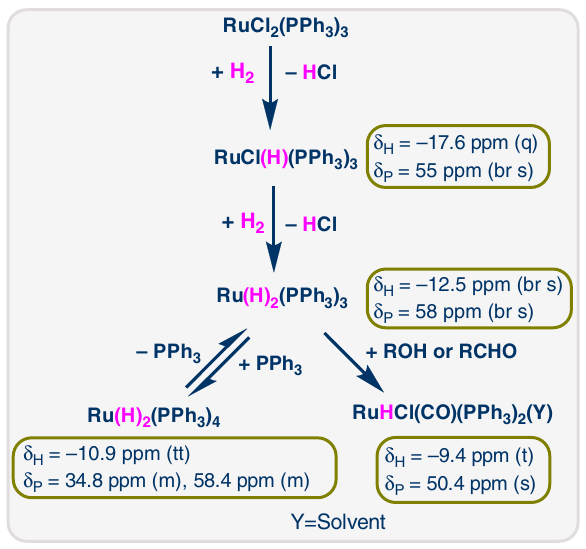
Fig. 7 Generation of different species from RuCl 2 (PPh 3 ) 3 in presence of hydrogen. RuCl 2 (PPh 3 ) 2 = precatalyst; Ru(H)Cl(PPh 3 ) 3 and Ru(H) 2 (PPh 3 ) 3 = active catalytic